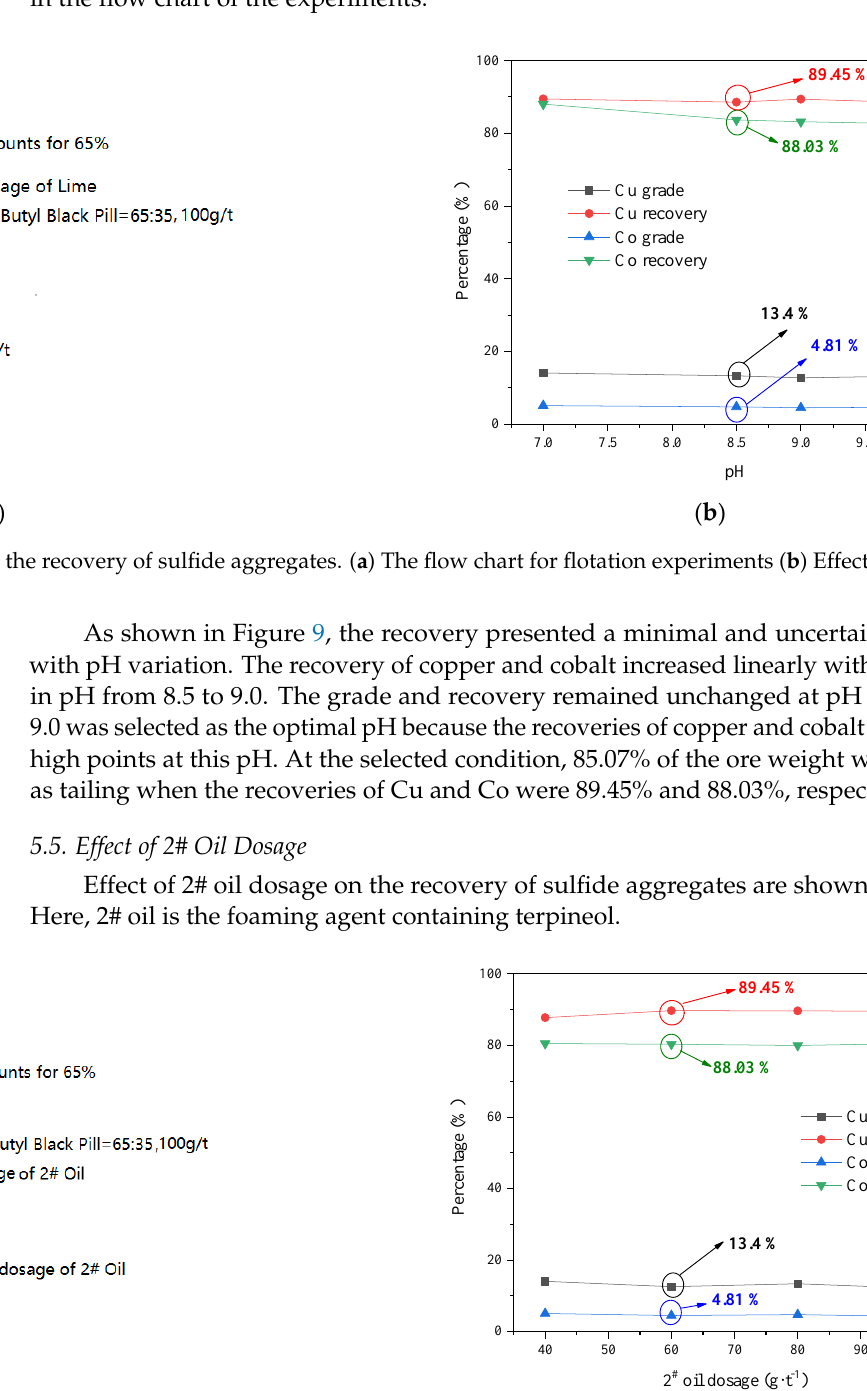
Figure 10. Effect of 2# oil dosage on the recovery of sulfide aggregates. ( a ) The flow chart for flotation experiments ( b ) Effect of 2# oil dosage on the flotation recovery.